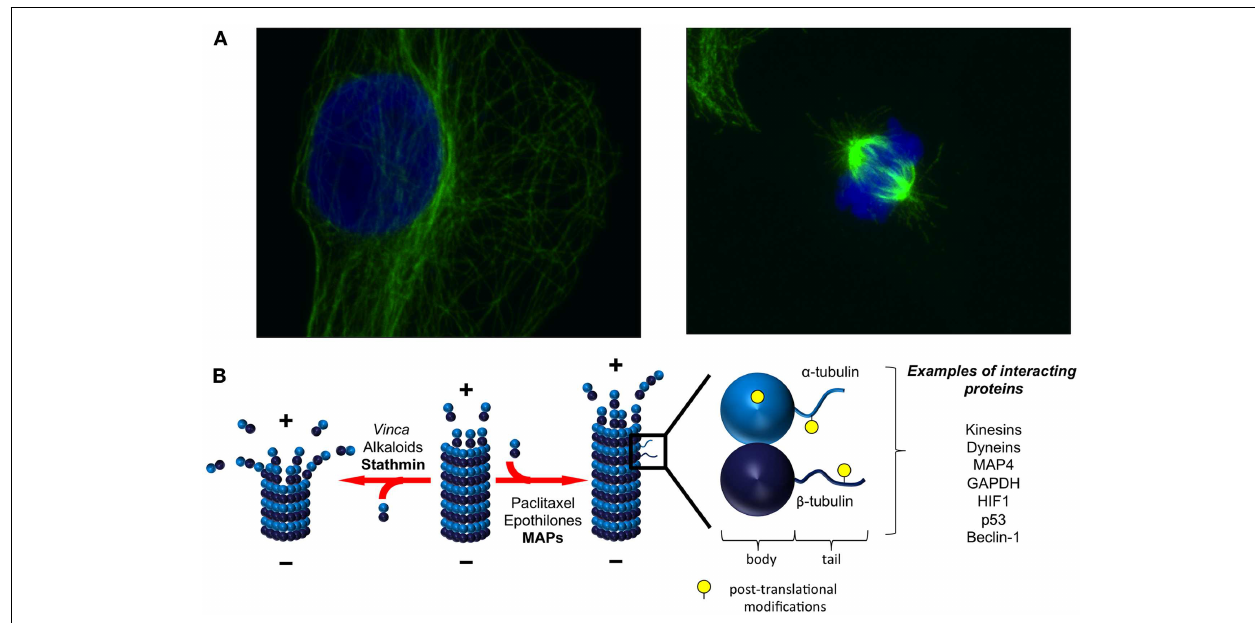
tubulin heterodimers is faster at microtubule plus ends than at microtubule minus ends. Both endogenous factors andTBAs regulate and influence microtubule dynamics. A variety of proteins involved in cellular homeostatic mechanisms and stress responses also interact with tubulins either in their soluble or polymerized forms. Post- translational modifications on tubulins influence these interactions. Adapted with permission from Macmillan Publishers Ltd: Nature Reviews Molecular Cell Biology [Ref. (9)], Copyright 2011 and Nature Reviews Cancer [Ref. (15)], Copyright 2010.